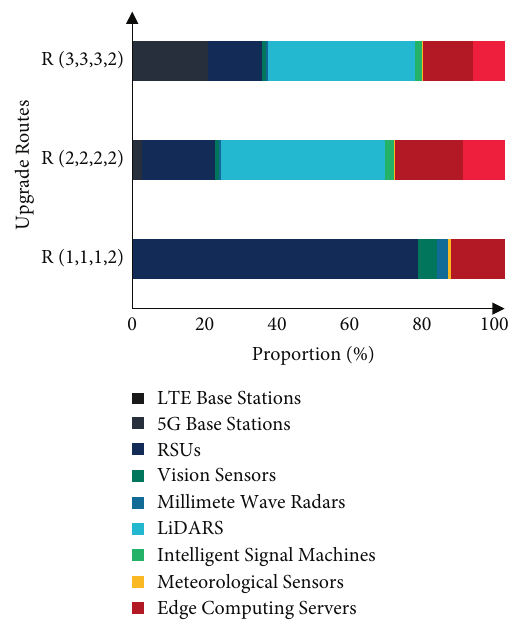
Figure 12: Share of cost components of one-time intelligent up- grade of transportation infrastructure in open urban road